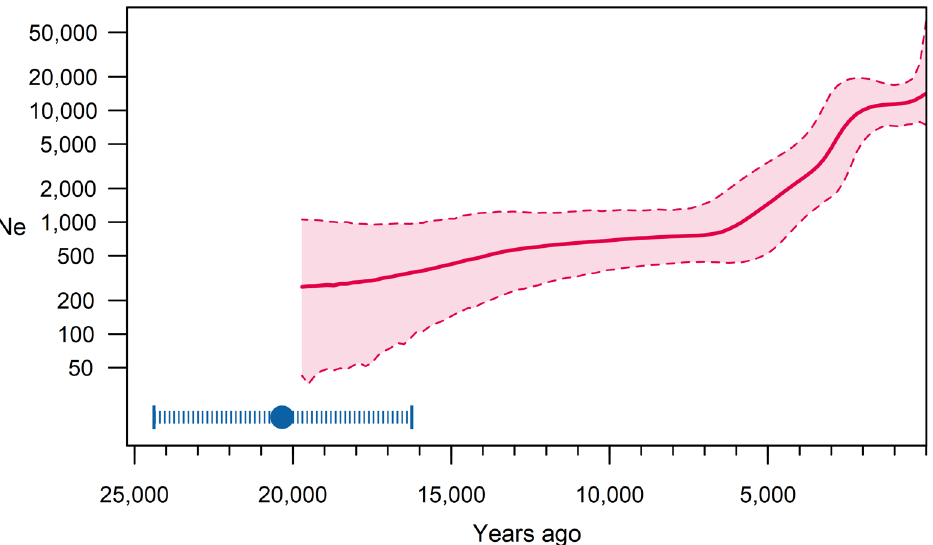
Figure 4. Bayesian skyline plot of haplogroup J1-M267. The solid line is the median estimate, while the dashed lines show the 95% HPD limits. Mean (filled circle) and 95% HPD intervals (pipes) for haplogroup J1-M267 coalescence time is provided in the figure. N e effective population